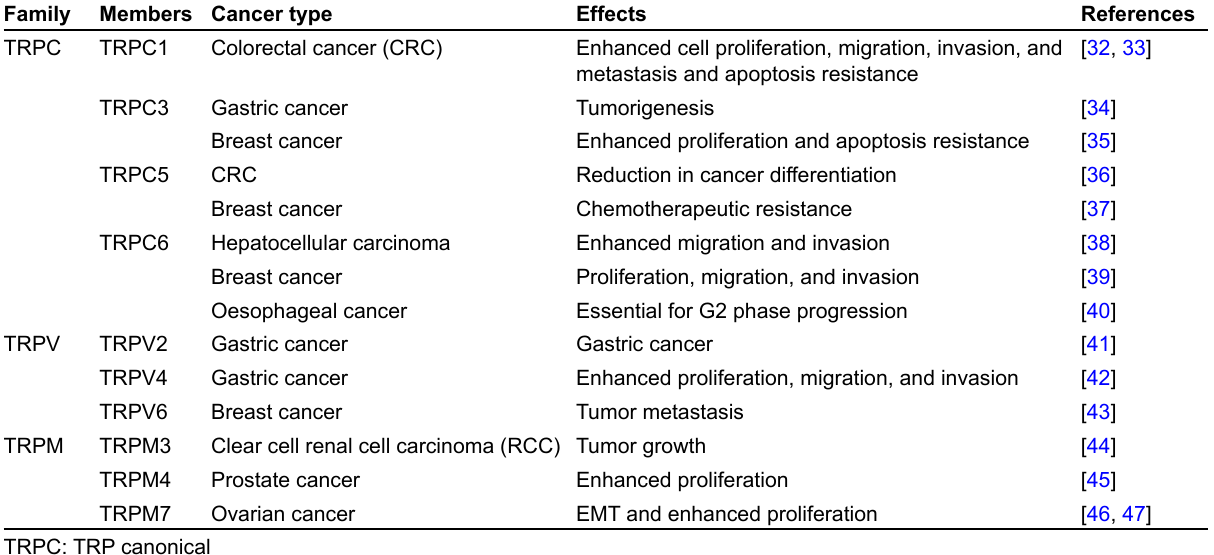
Table 1. TRP channels and their functions in different cancers Family Members Cancer type